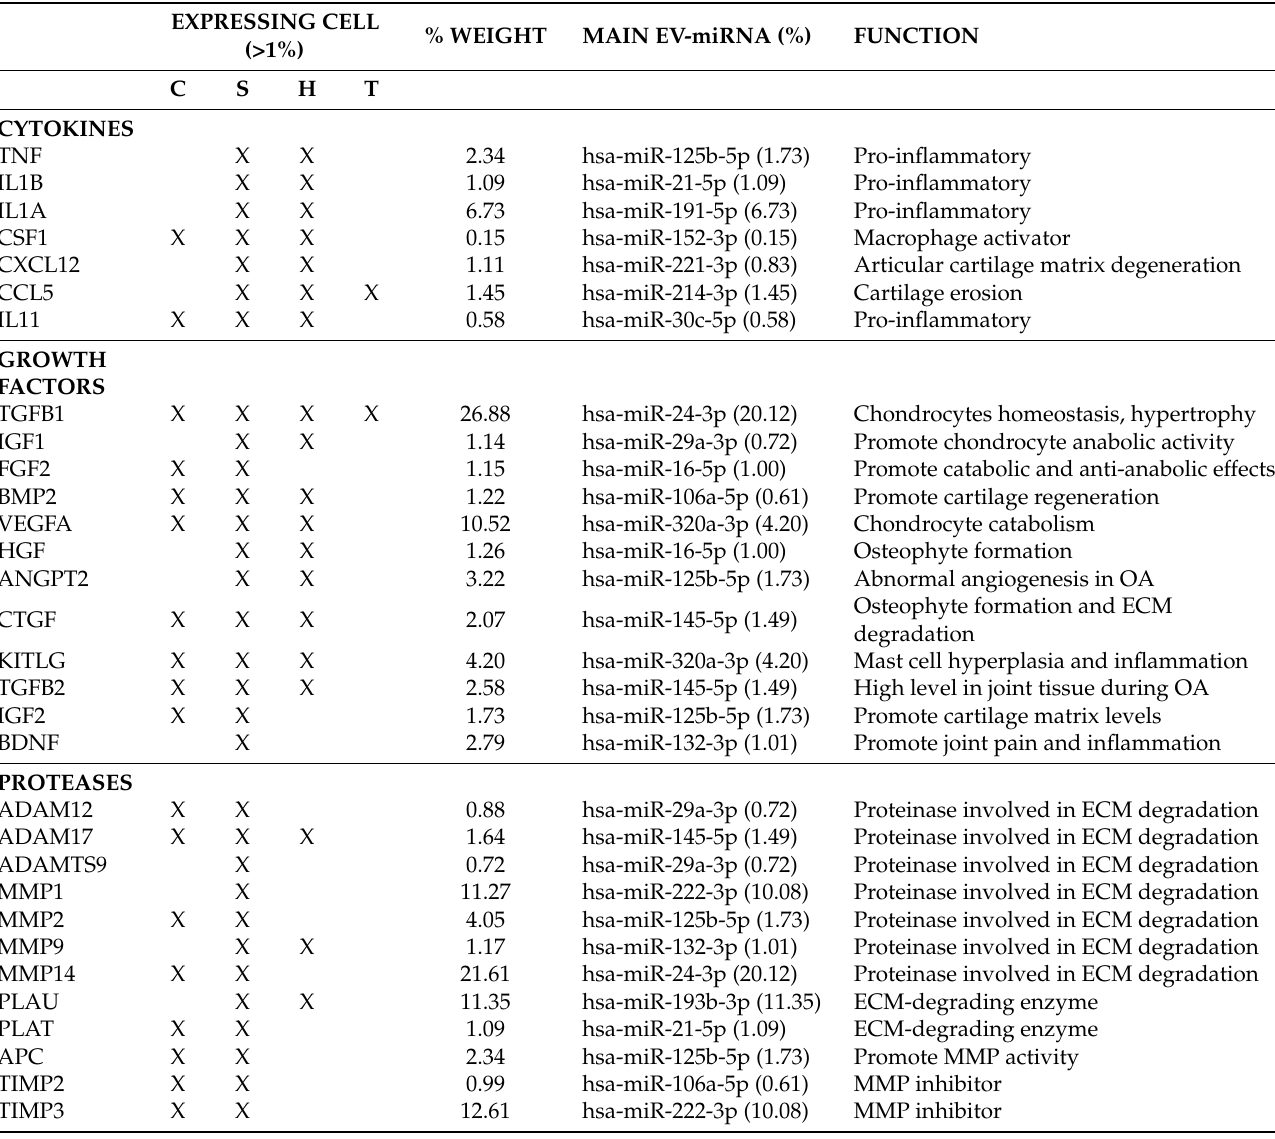
Table 4. OA-related factors targeted by